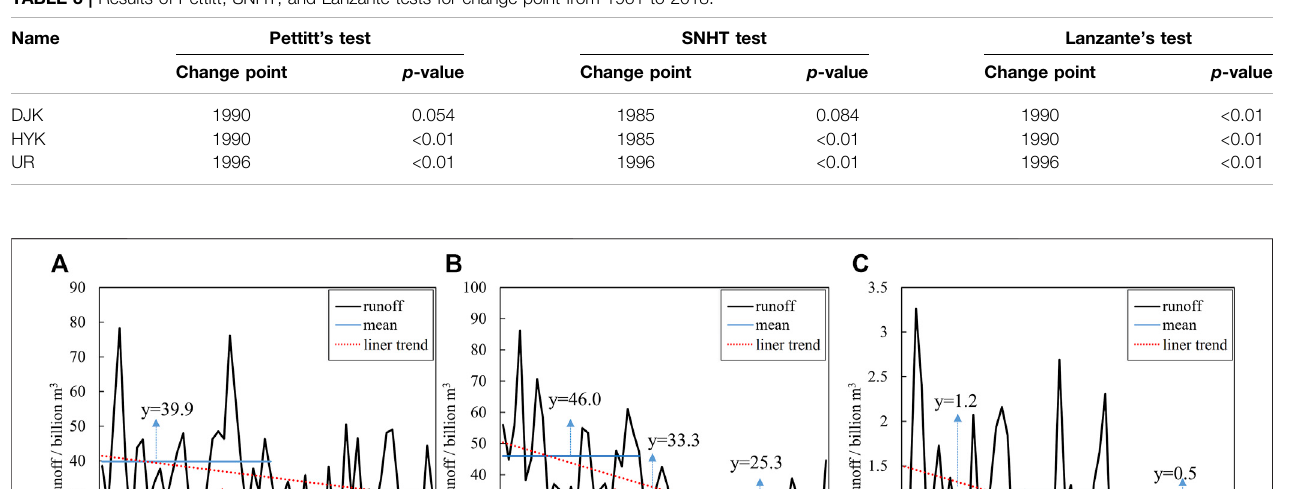
Frontiers in Environmental Science |